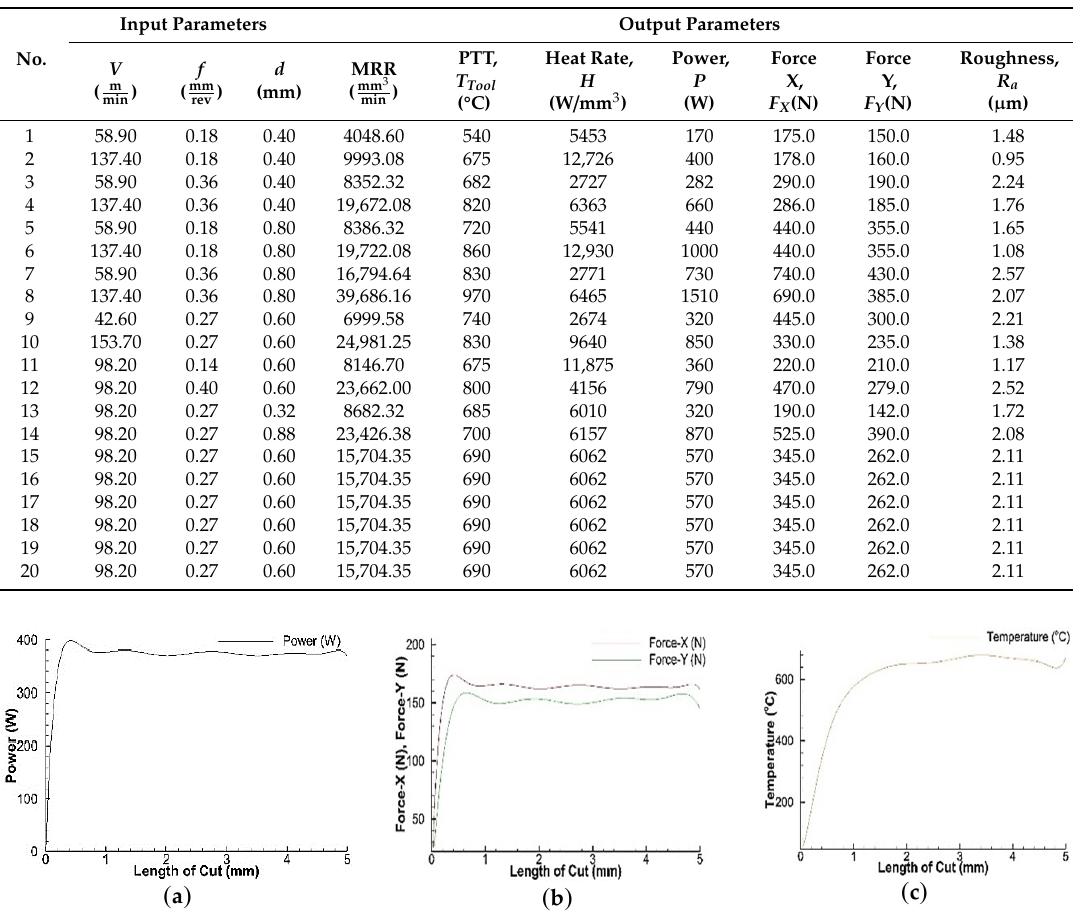
Figure 3. ( a ) Power ( b ) Temperature ( c ) Force X and Y results of simulation for cutting condition 2, cutting speed 137.40 m / min, feed 0.18 mm / rev and depth of cut 0.4